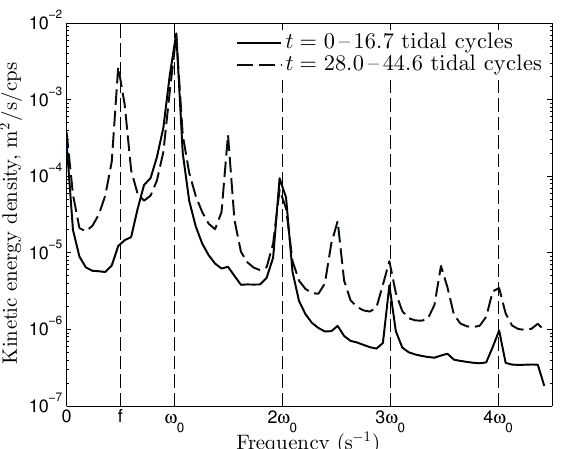
Figure 4. The power spectrum for turbulent kinetic energy, for the simulation with γ = 0.68, f = 7 × 10 − 5 s − 1 , and λ x = 8.57 km, shown for two different time periods. Early in the simulation the spectrum is dominated by the forcing frequency ω 0 and higher harmonics n ω 0 (where n is a positive integer), while later in the simulation additional peaks at frequencies f + n ω 0